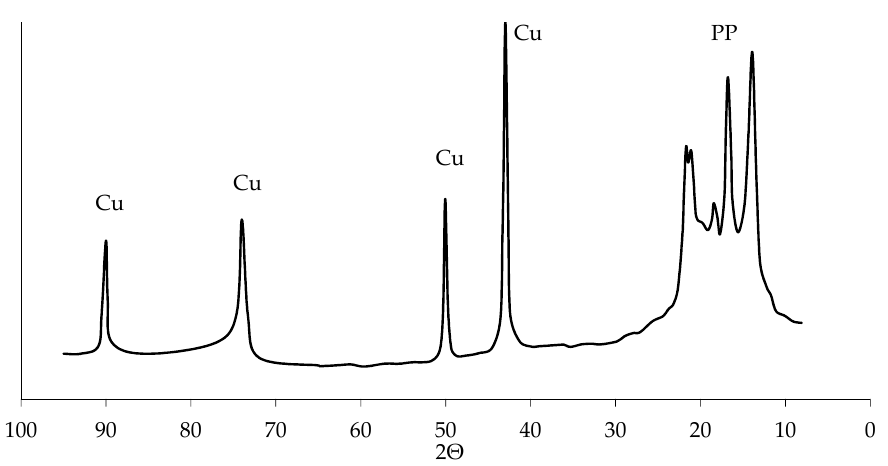
Figure 15. X-ray film of copper coating obtained by chemical recovery.